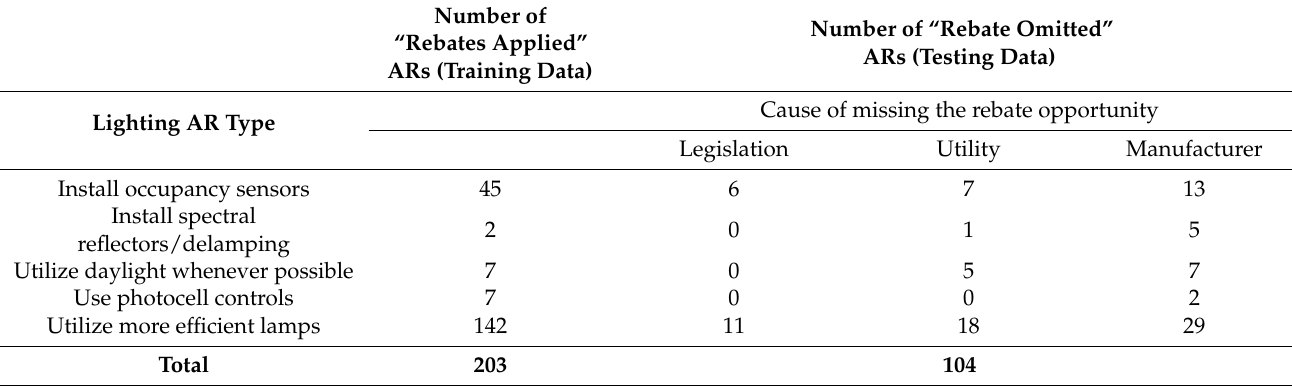
Table 3. Number of rebate-applicable lighting ARs used for training and testing the ML